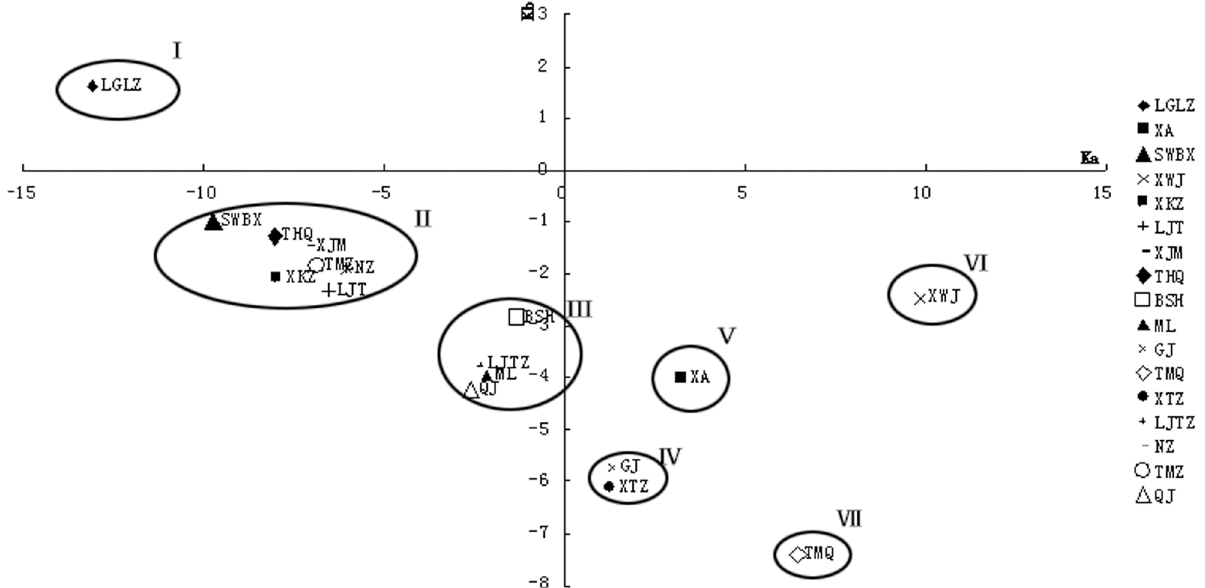
Fig 2. The result of matter element analysis in main stream of Taizihe River.